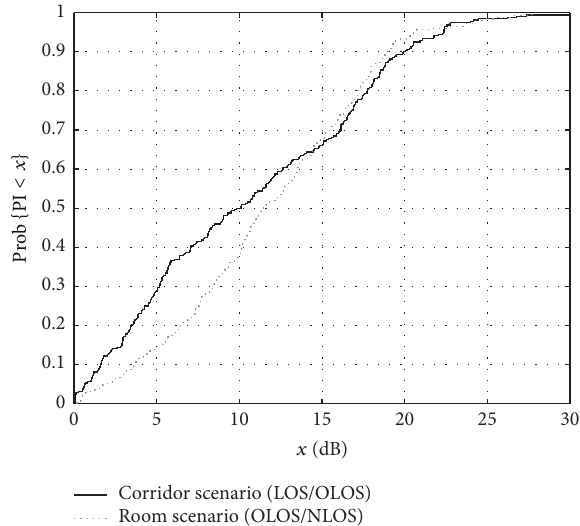
Figure 3: Experimental CDF of the PI in the considered